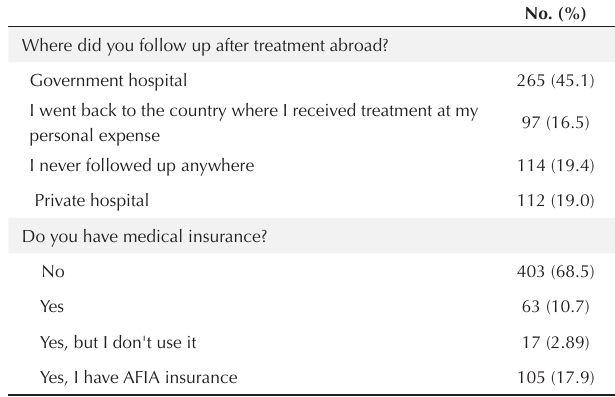
Table 6. Follow up, and Insurance Status of the Respondents